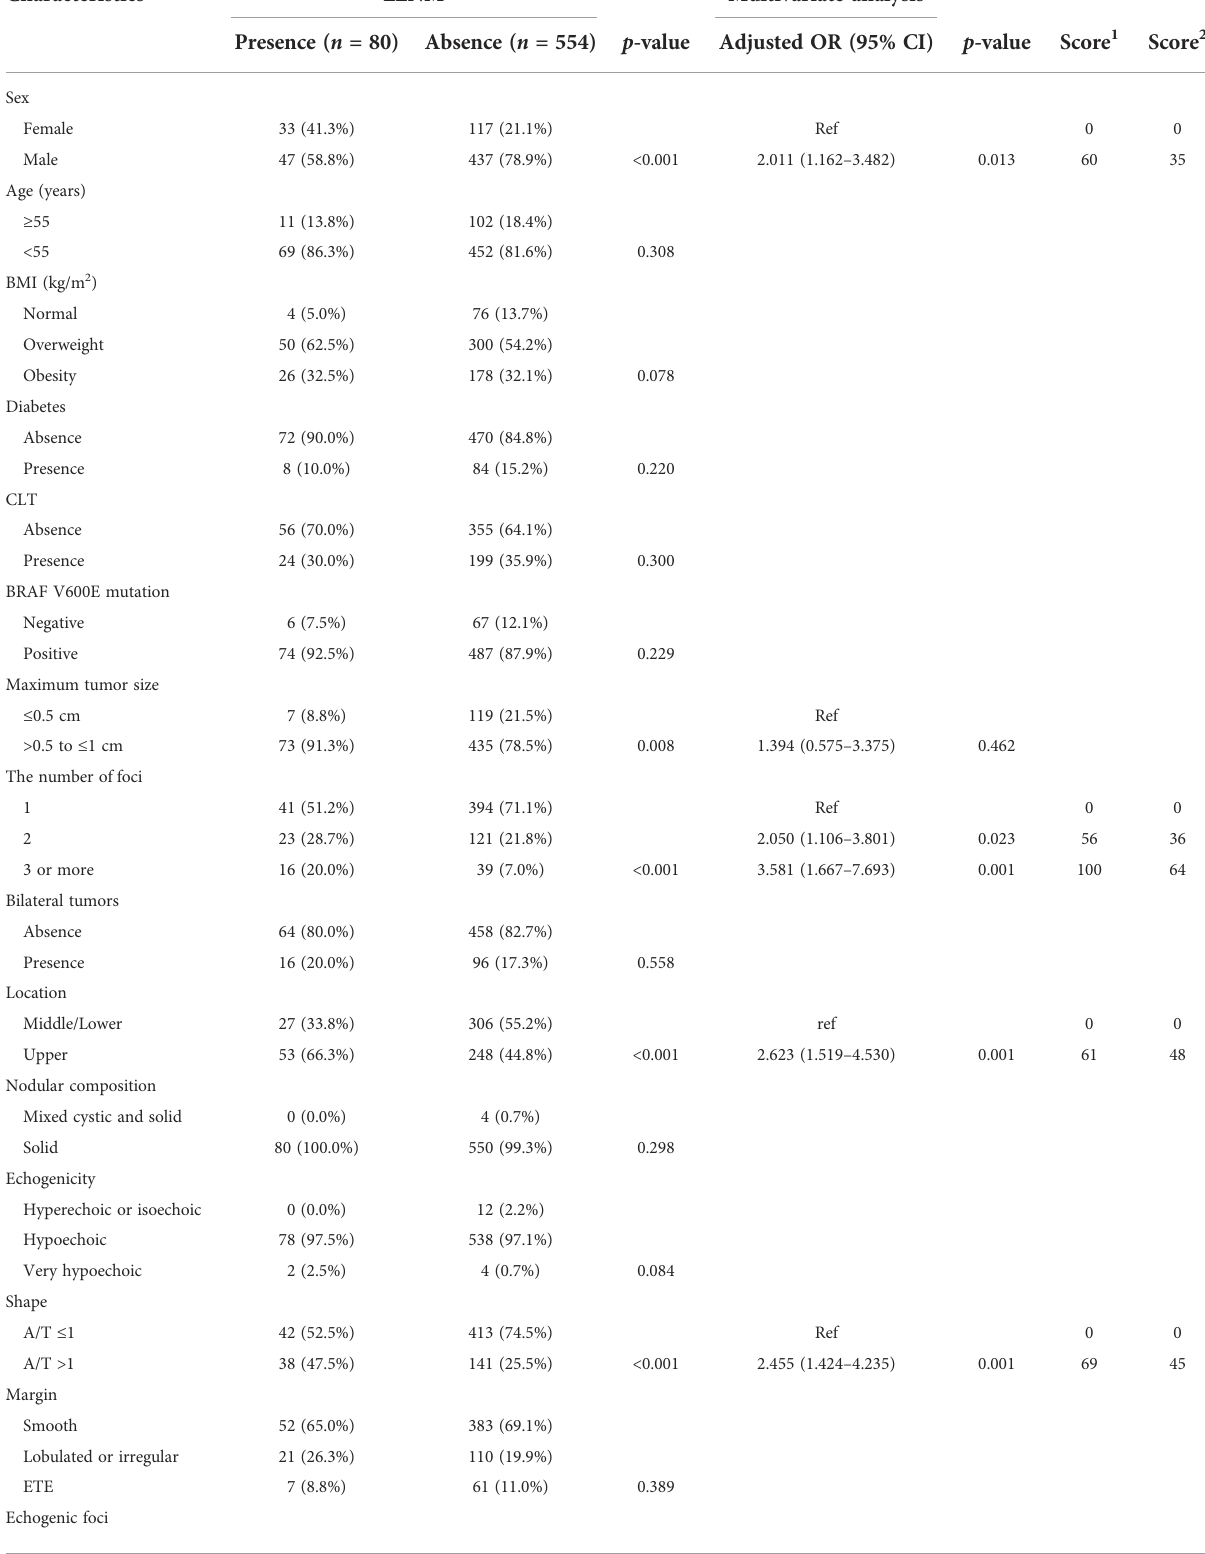
TABLE 3 Univariate analysis and multivariate analysis of factors associated with LLNM in patients with